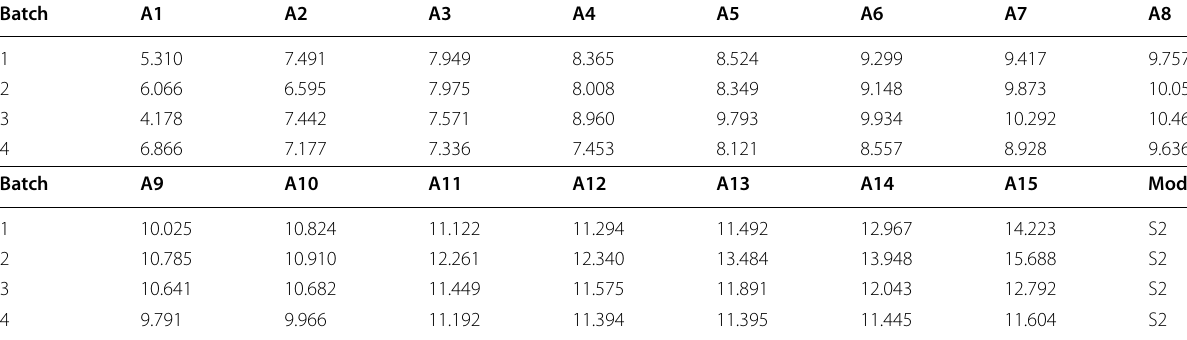
Table 8 Centroid offset data for batches 1–4 of cabin A of model S1